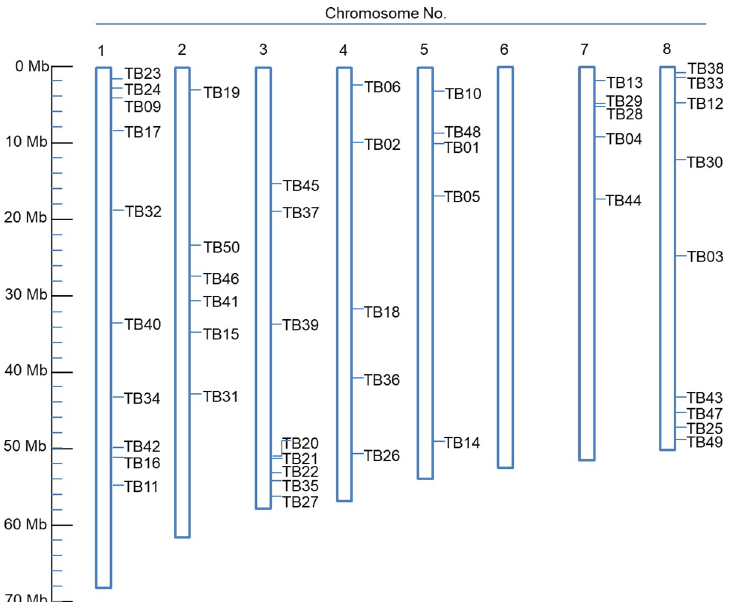
Fig 4. Schematic of the chromosomal distribution of the tartary buckwheat InDels. The number of the chromosome is shown on each chromosome of a reference genome of